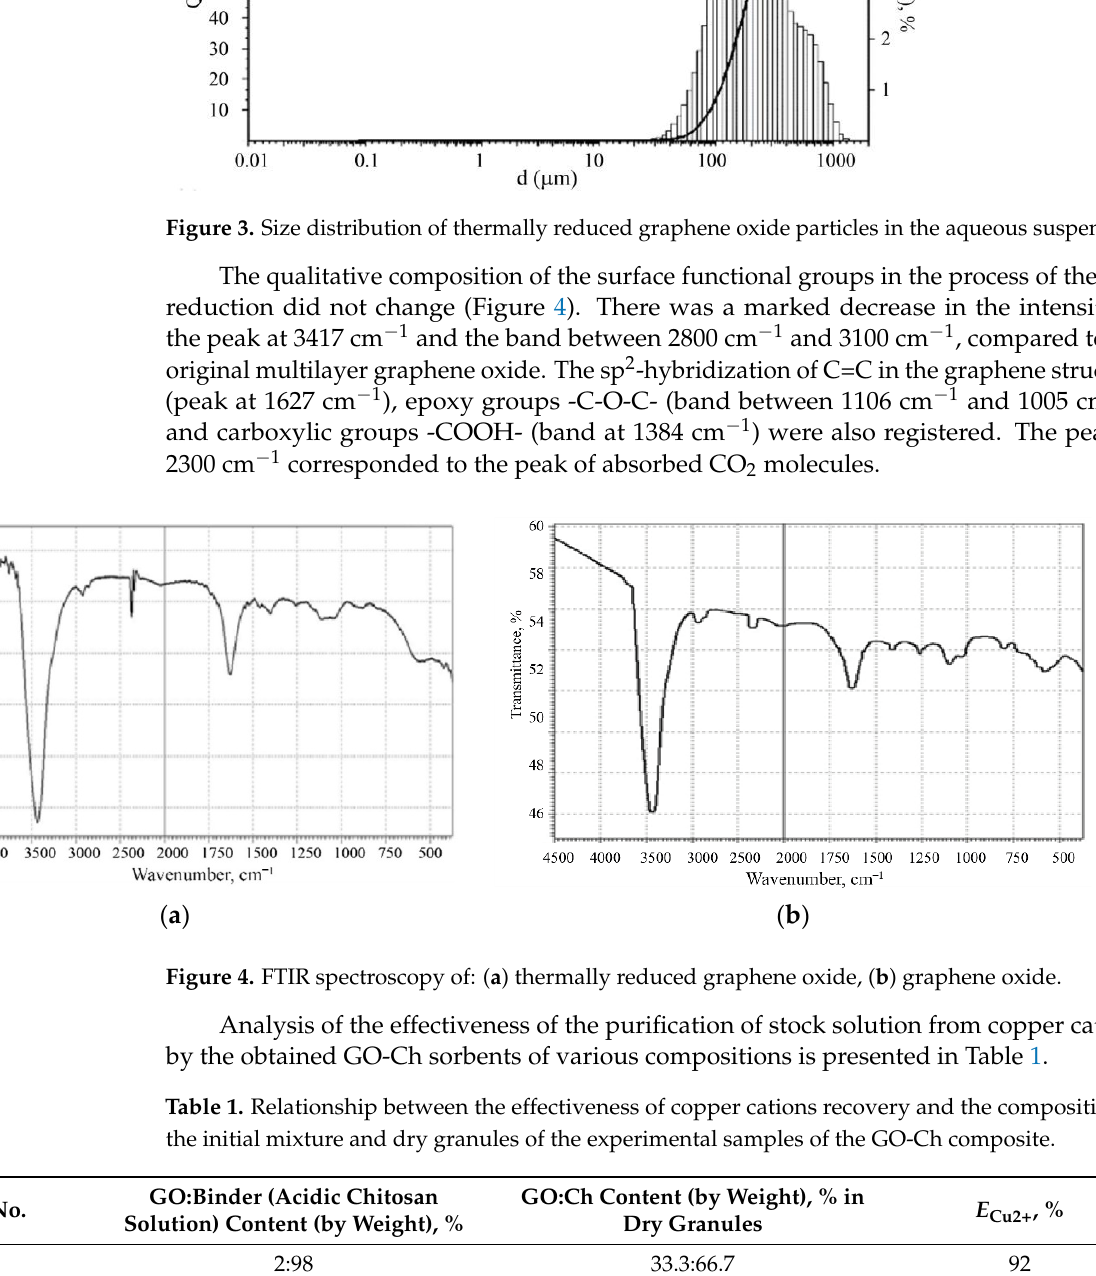
The final and initial concentrations were used to determine the purification